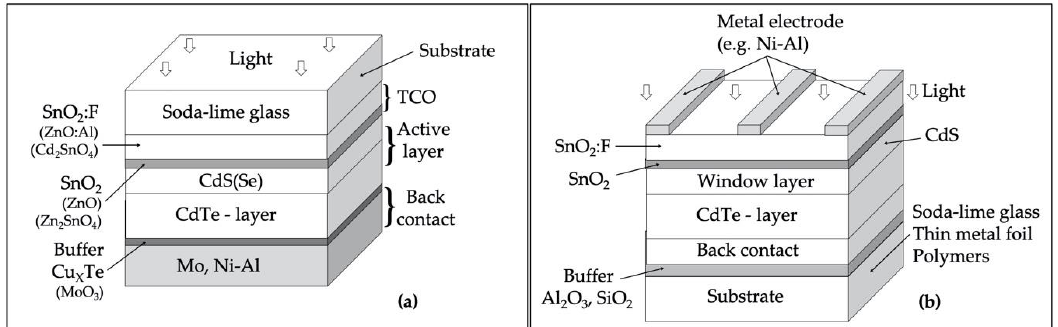
Figure 6. The CdTe/CdS solar cell; ( a ) superstrate configuration (light enters through the substrate), ( b ) substrate configuration (substrates could be